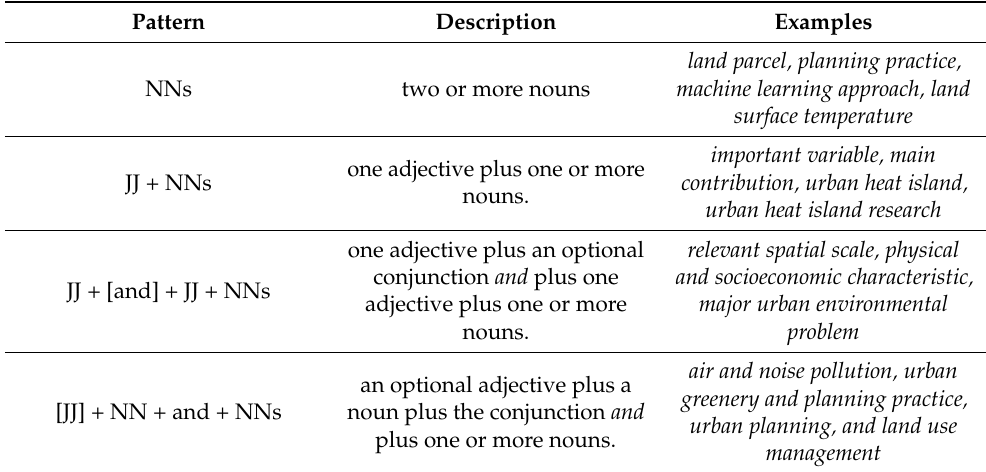
Table 1. Syntactic patterns for candidate words and examples.